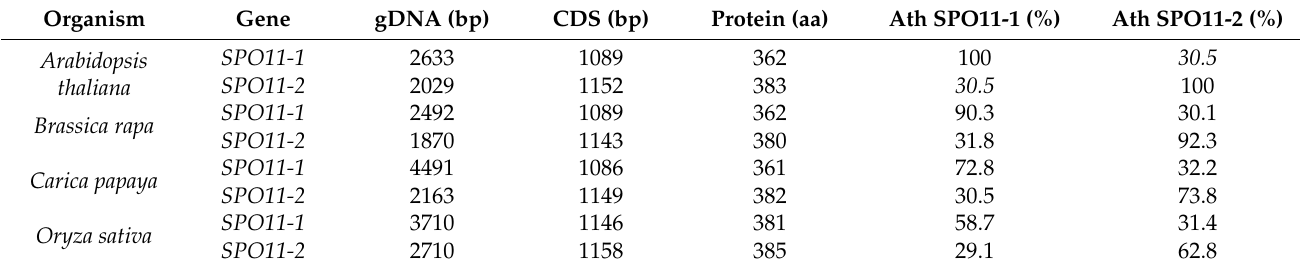
Table 2. Pairwise comparison of AthSPO11-1 and AthSPO11-2 to SPO11 proteins from organism used for the complementa- tion